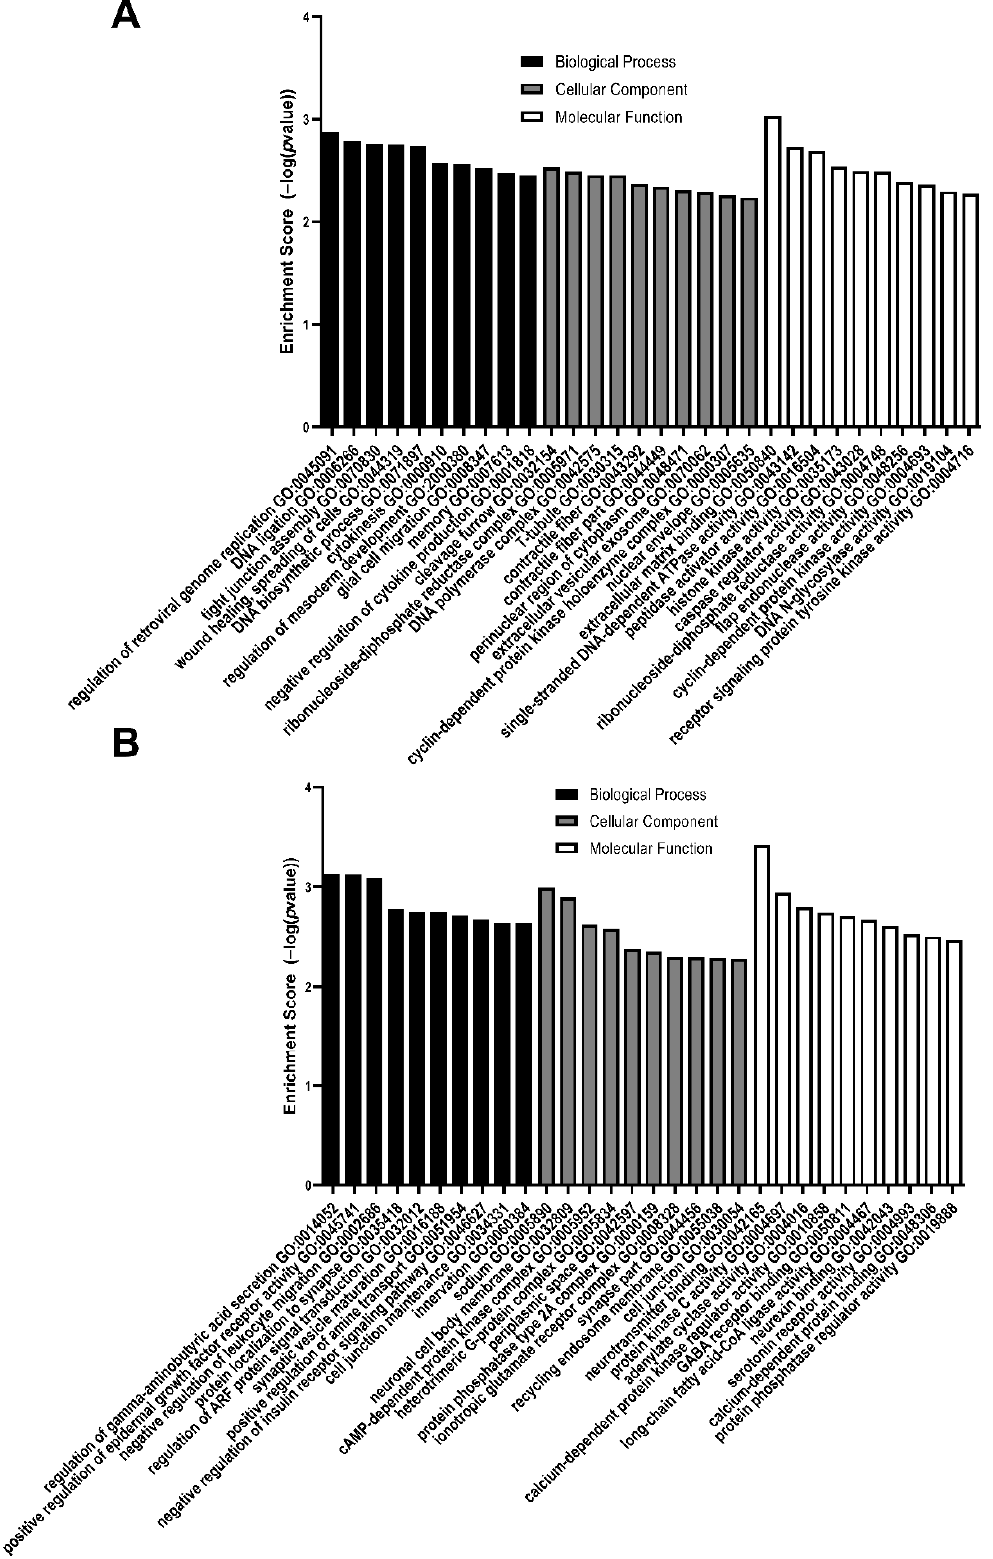
Figure 6. Enrichment scores of the top 10 GO biological processes, cellular components, and molecular function enriched from differentially expressed genes that are ( A ) upregulated or ( B ) downregulated in MMC spinal cords compared to vehicle at E15. All GO pathways were > 1.5-fold and p < 0.05.